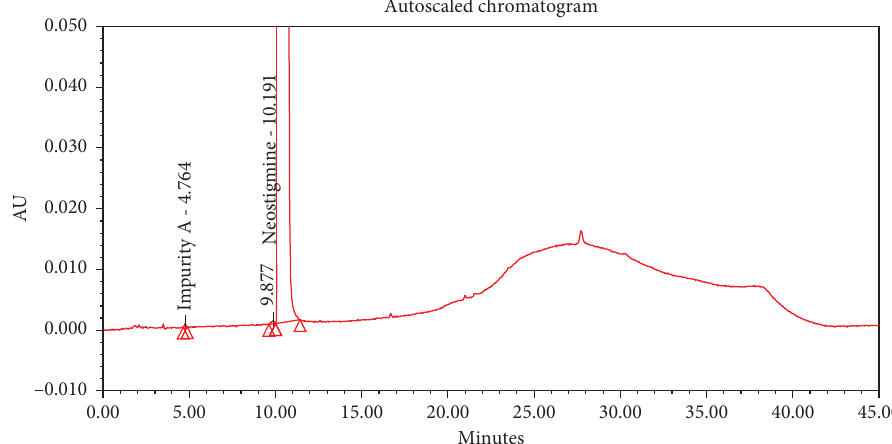
Figure 5: Chromatogram of control sample of neostigmine methylsulfate API (1000ppm).